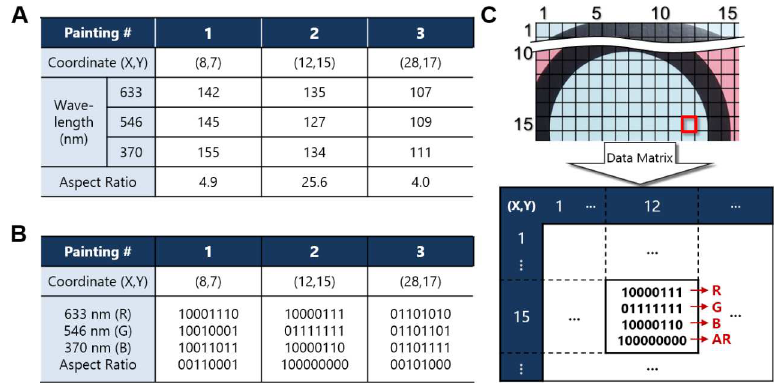
Fig 8. Processing for creating the database. An exampleof creating the databaseof the genuineworks. (A) The decimaldatabaseof the red boxes in Fig 3D, 3E and 3F. (B) The convertedbinary numerical values from the decimalnumbers. (C) The resultingmatrix databasefor